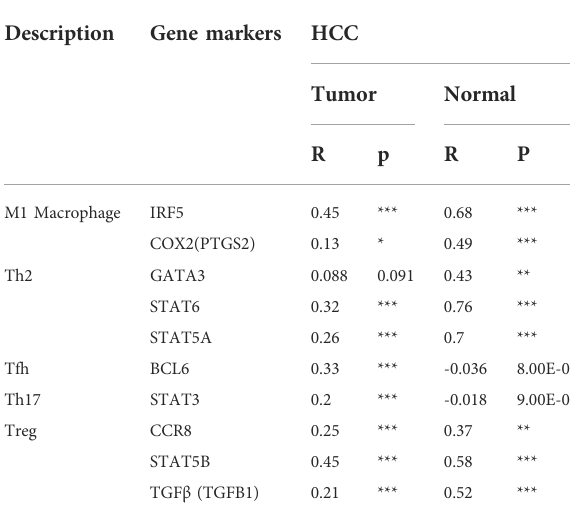
TABLE 3 Correlation analysis between PIGC and marker genes of immune cells in